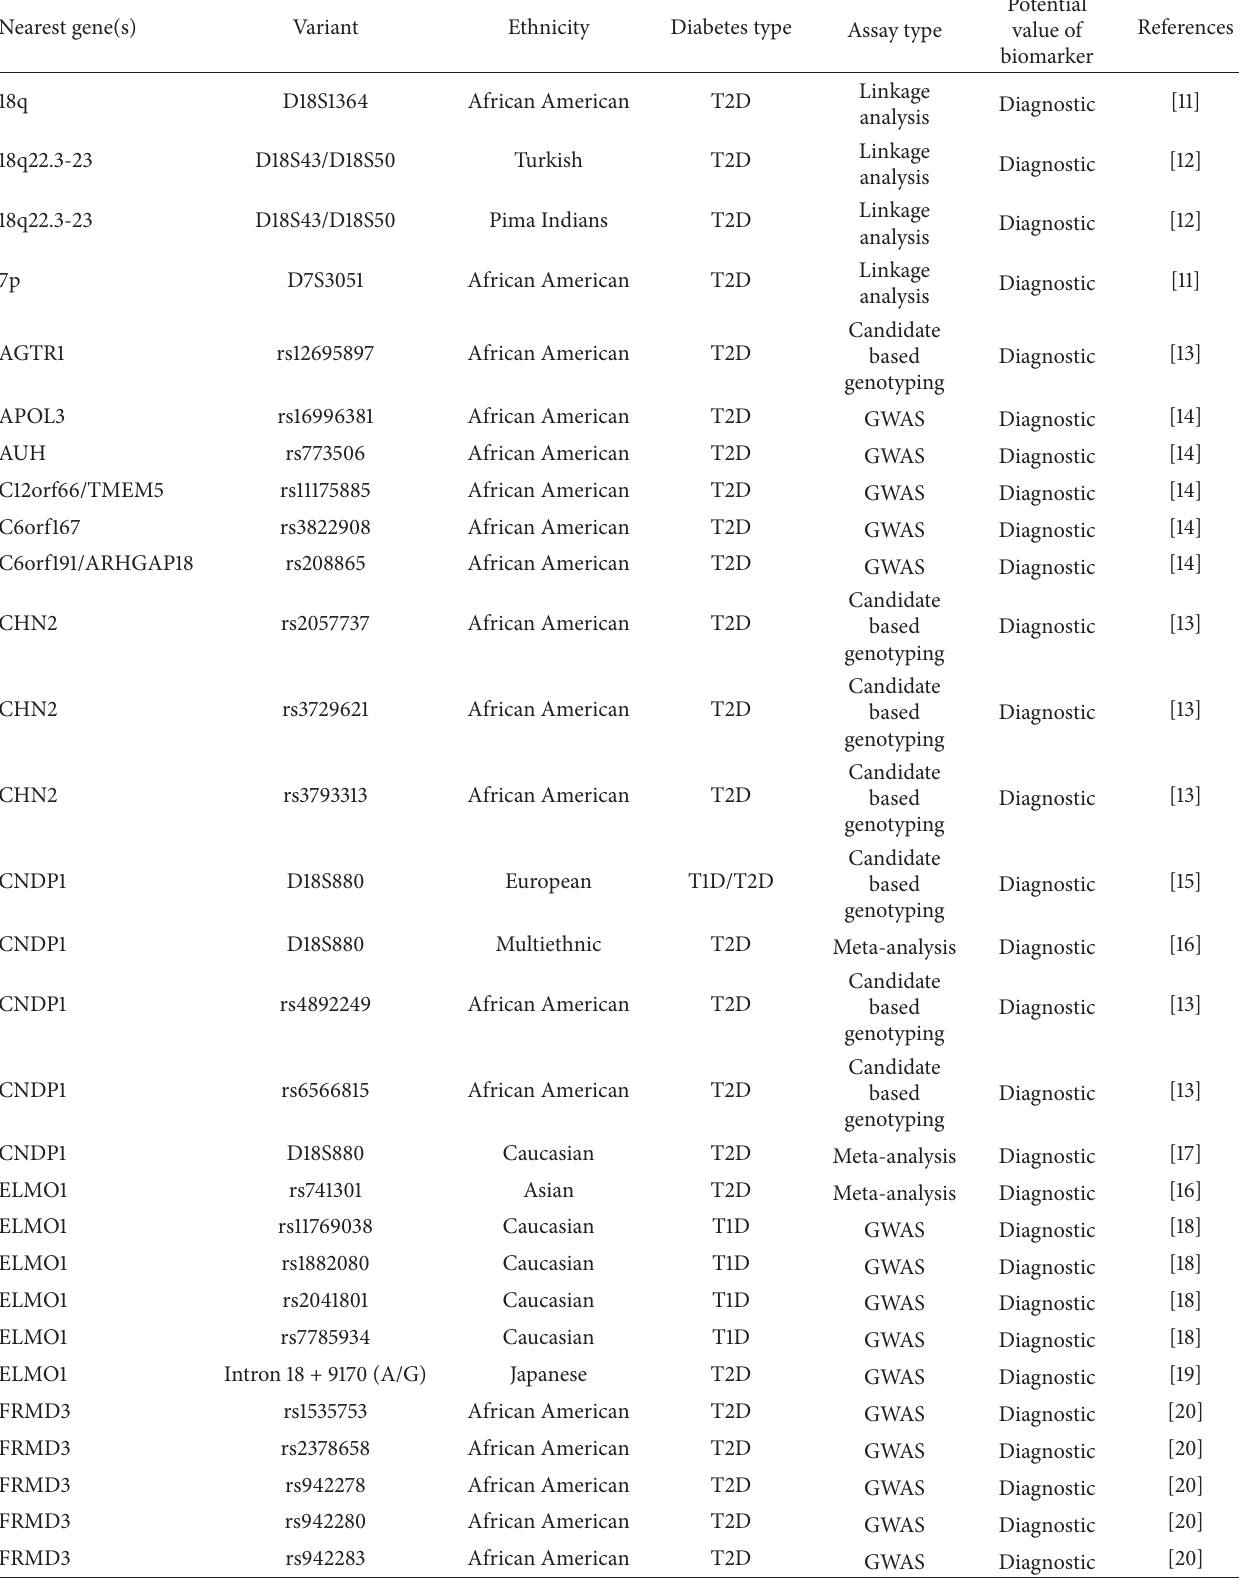
Table 1: Genetic markers. Collection of significant genetic markers, listed